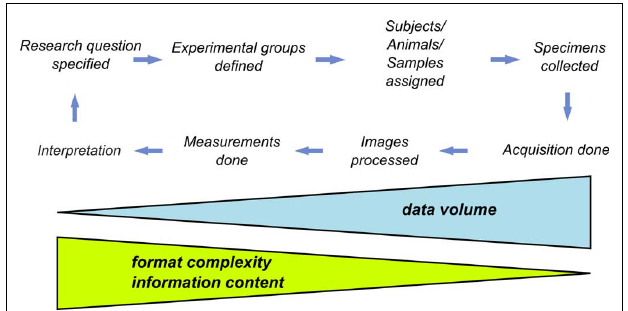
FIGURE 1 |The experimental workflow. The experimental workflow in life sciences tries to answer the initially posed research question via quantitative analysis of multiple experimental trials. Each step requires the application of typically different hardware and software tools frequently using incompatible data